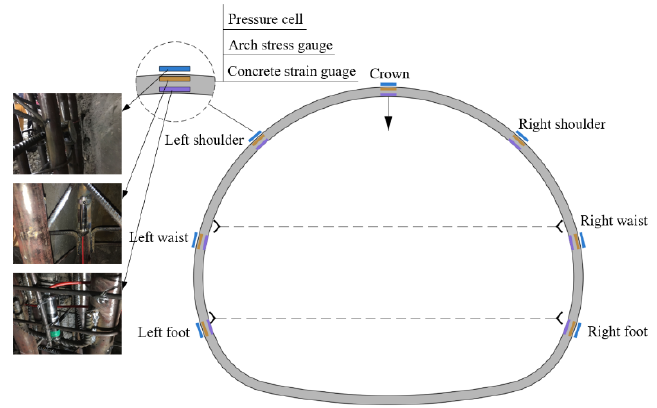
Figure 27. Schematic diagram of the layout of monitoring components.